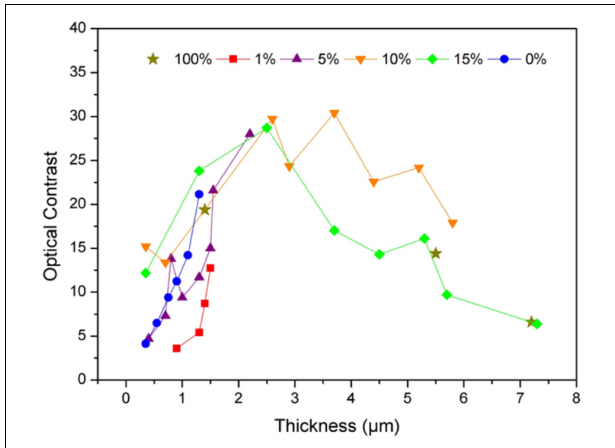
FIGURE 7 | Optical contrast (cid:49) E* in relation with the thickness of the electrochromic layer and the wt% V 2 O 5 in the PEDOT:PSS ink.